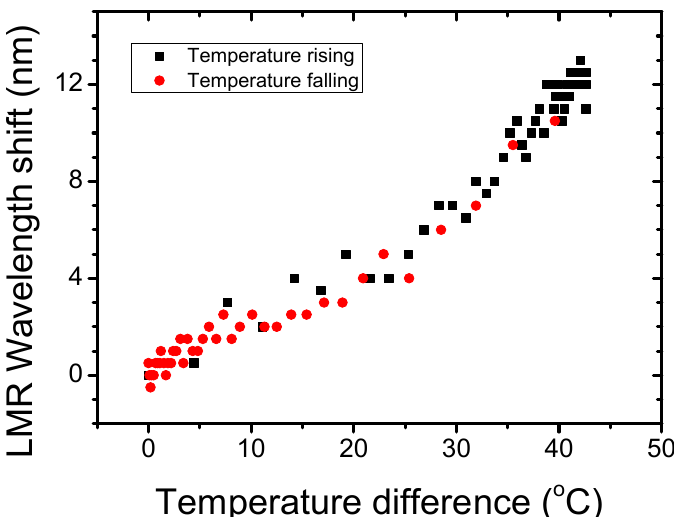
Figure 9. The correlation between the shift in the LMR wavelength and temperature difference for an increase and decrease in the temperature of glycerol, where the black squares and the red circles represent the respective experimental data of temperature rising and falling.